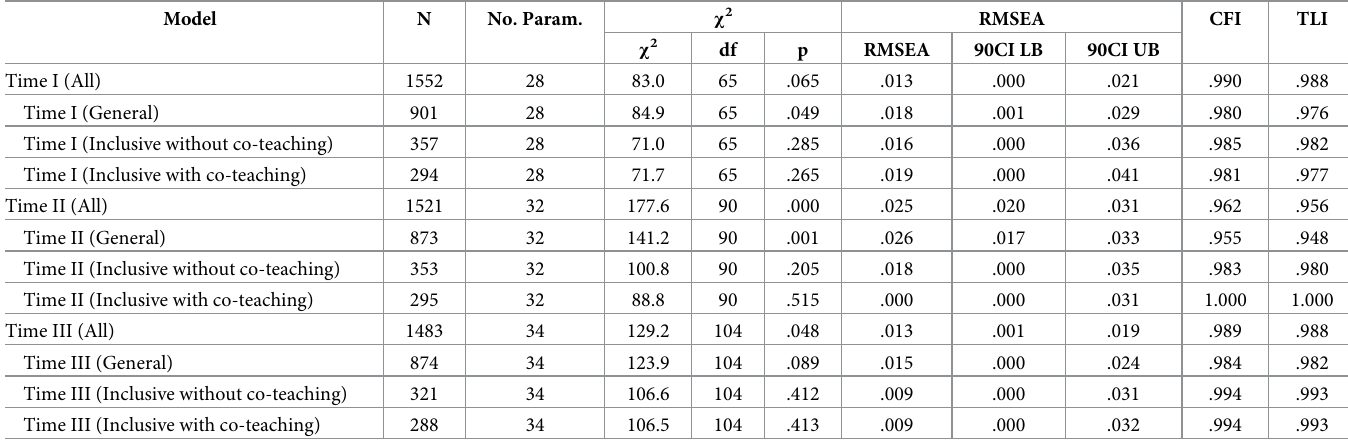
Table 6. Fit indices for results in